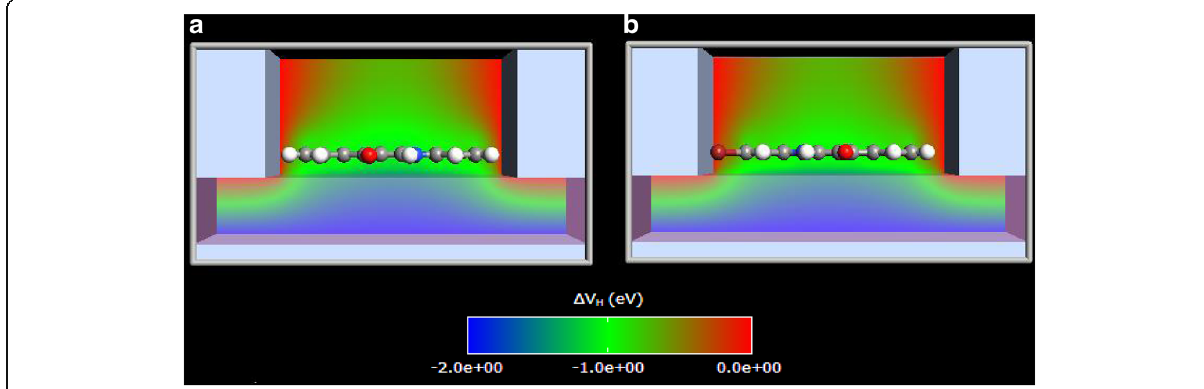
Fig. 4 The geometry of the molecular SET environment of indigo ( a ) or Tyrian purple ( b ). Both molecules are modeled within an electrostatic environment, which simulates metal source-drain electrodes on top of a dielectric substrate (shellac) with a metal back-gate. Δ V H is denoted for the Hartree potential difference calculated by solving the Poisson equation. The contour plot shows the induced electrostatic potential for a V G value of 2 V and zero source-drain bias. The molecular geometries were obtained by relaxing the molecules in the neutral